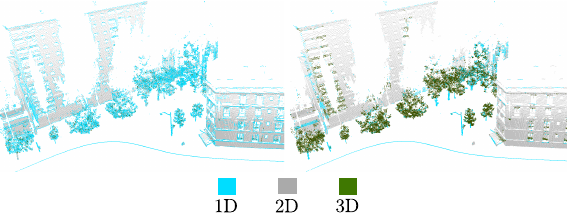
Figure 8: Dimensionality labelling for the MMS F dataset using a constant neighborhood size for the whole point cloud ( left ), and the optimal value per point selected with E f ( right ). The con- stant neighborhood size corresponds to a 1 m